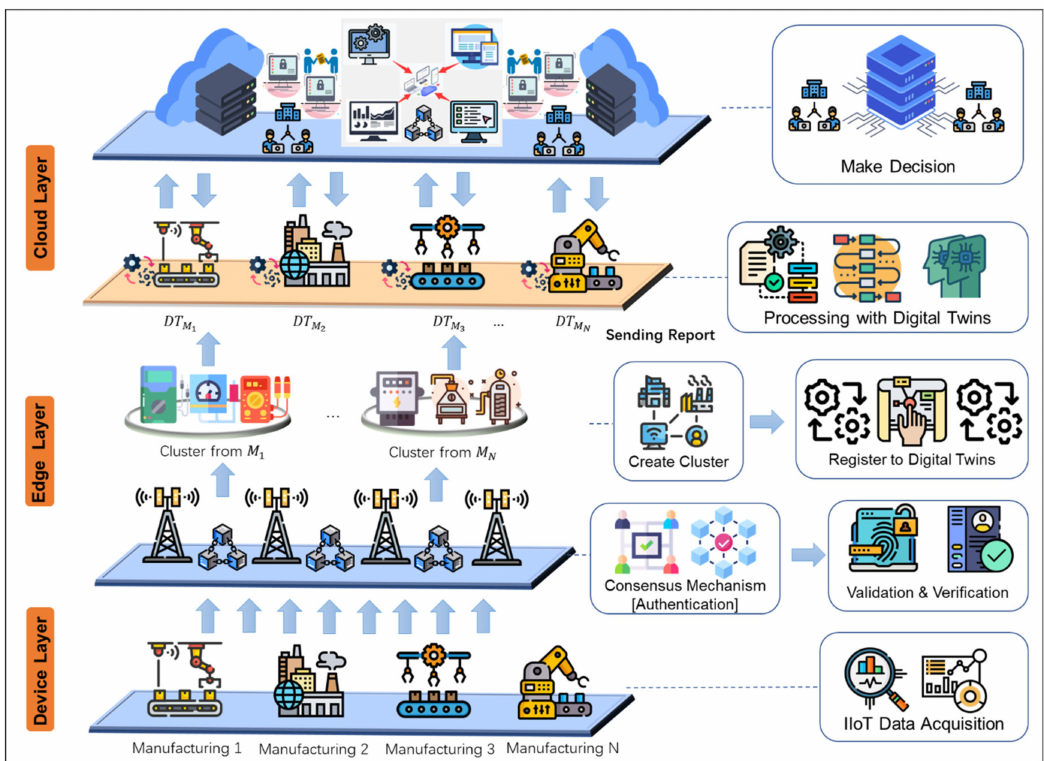
Figure 1. Proposed blockchain and digital twin-based heuristic multi-cooperation scheduling